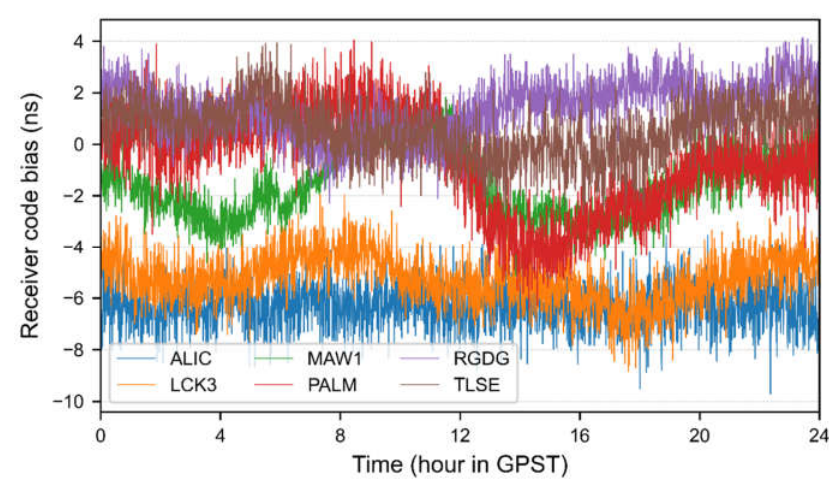
Figure 6. Time series of RCBs extracted by Undifferenced-RCB model on DOY 031.